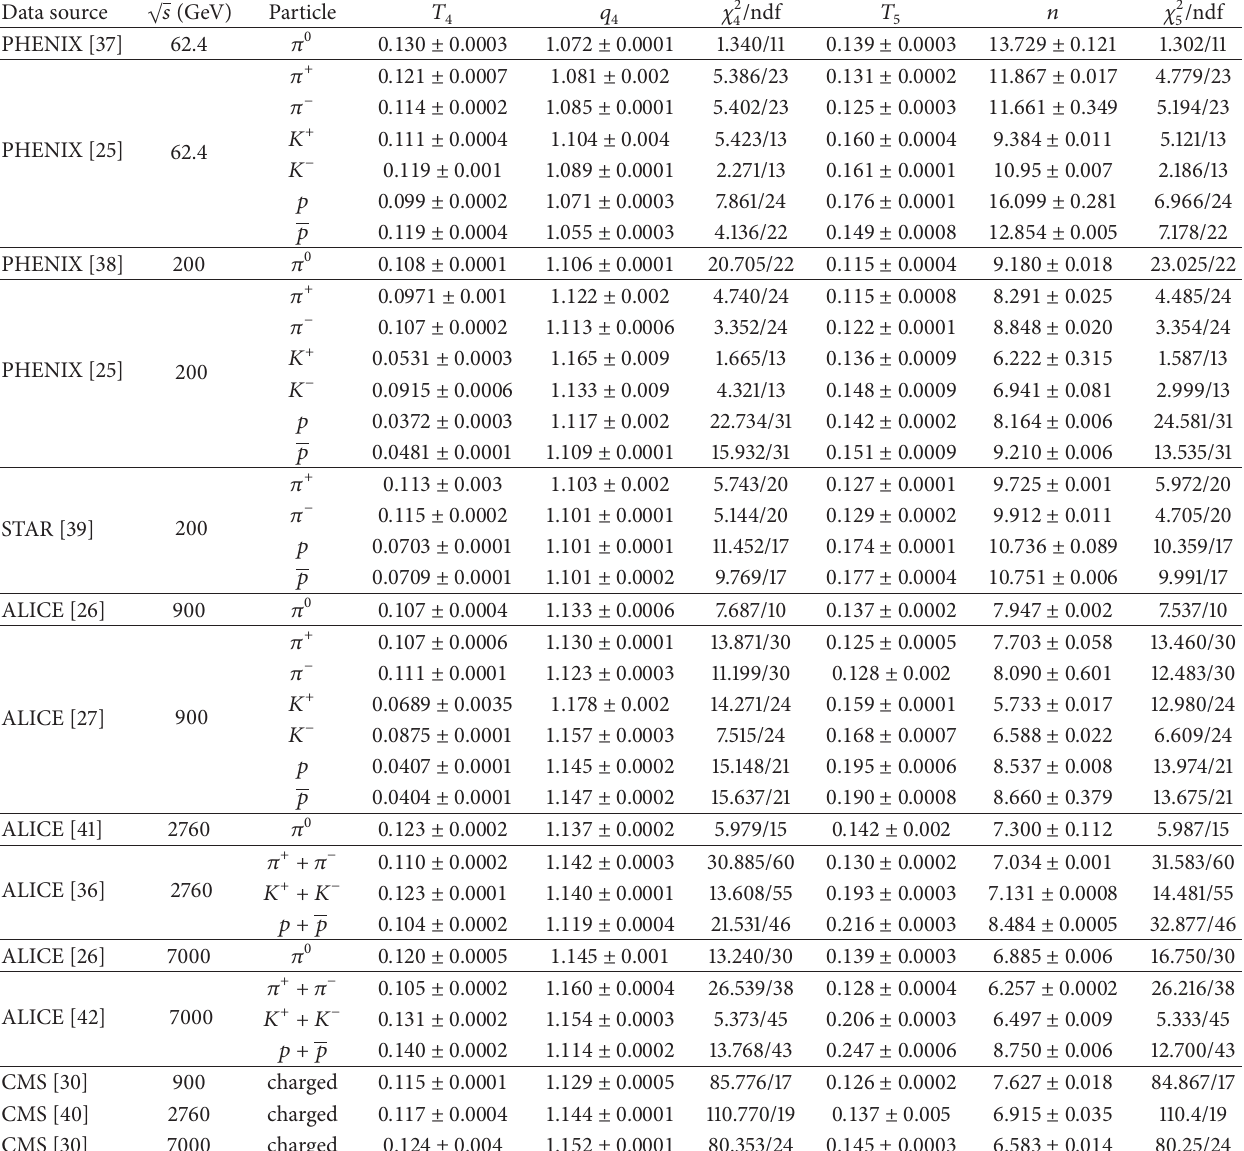
Table 2: The fitting parameters 𝑇 4 and 𝑞 4 in (10), 𝑇 5 and 𝑛 in (2), the errors of parameters, and 𝜒 2 /ndf for the particle spectra in 𝑝 + 𝑝 collisions. The unit of 𝑇 is